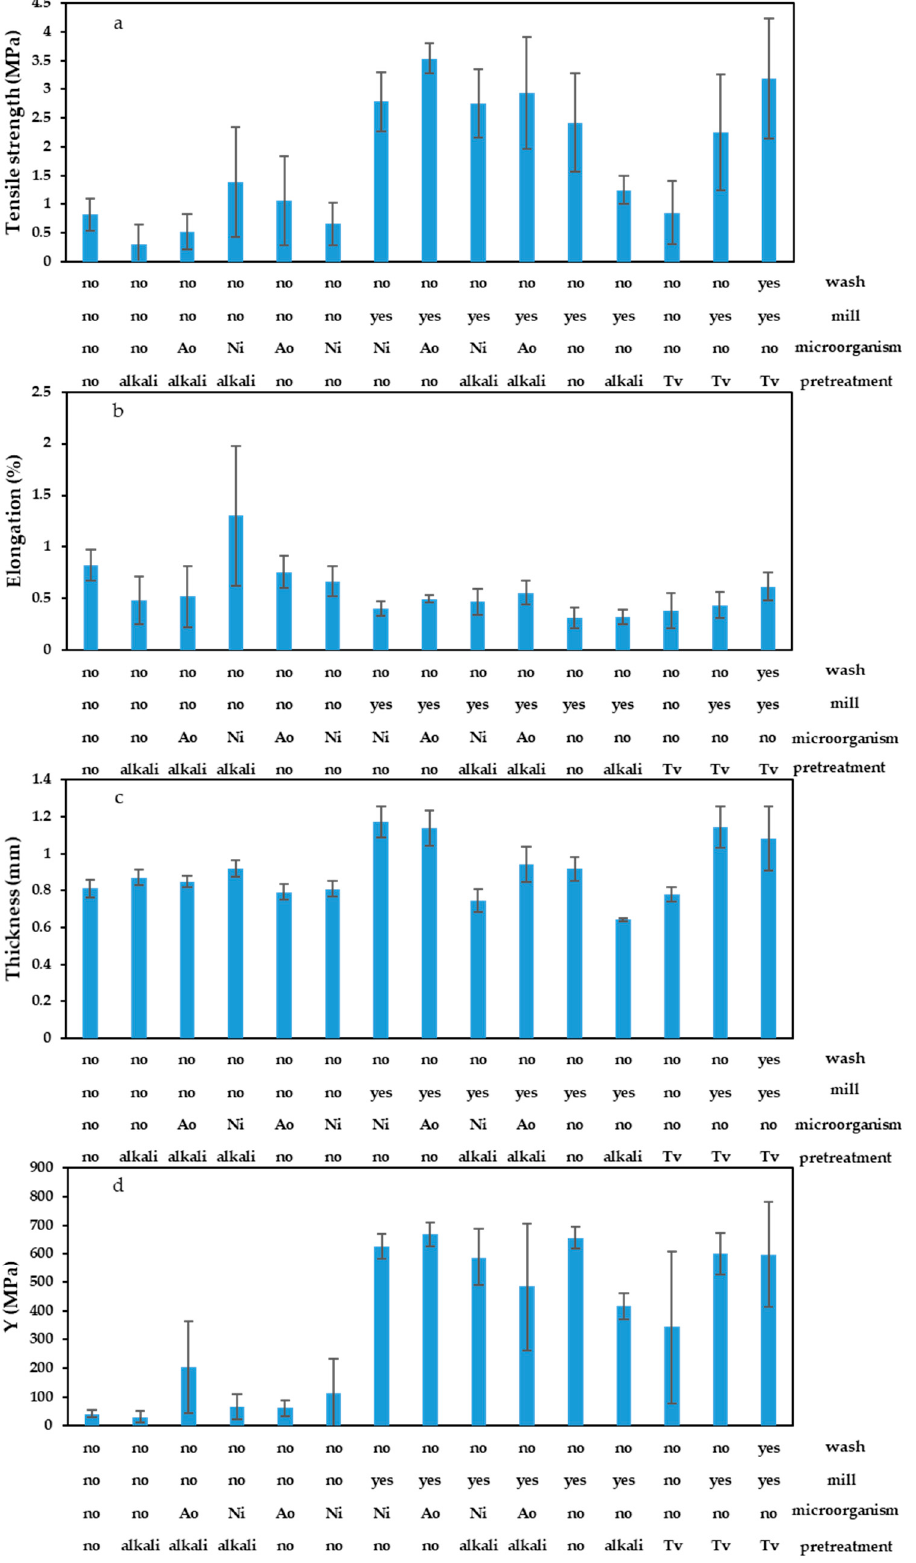
Figure 3. ( a ) Tensile strength (MPa), ( b ) elongation at break (%), ( c ) thickness (mm), and ( d ) Young’s modulus (MPa) of the films made with wheat straw. Individual standard deviations were used to calculate the intervals. Number of replicates = 5; confidence interval for the means of 95%. Ni, Ao, and Tv stands for N. intermedia , A. oryzae, and T. versicolor , respectively.